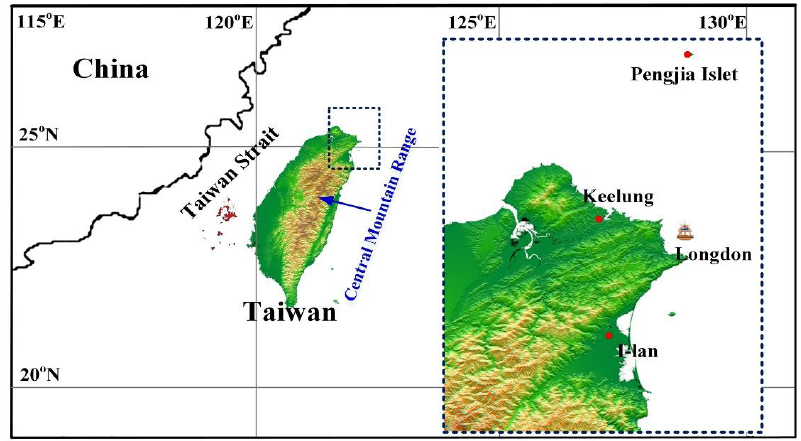
Figure 1. Location of the meteorological stations and a buoy.